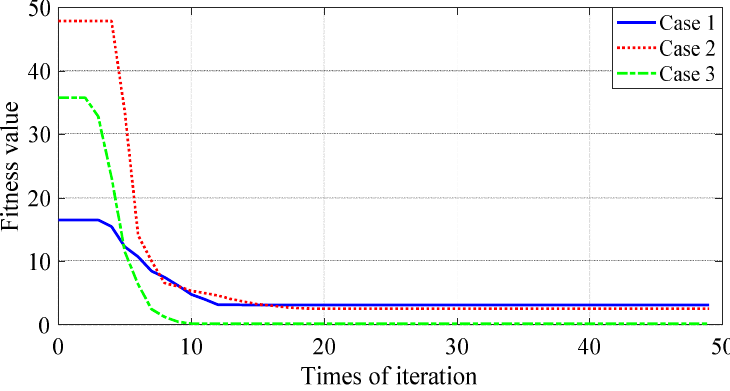
Figure 14. The best fitness value of each iteration.